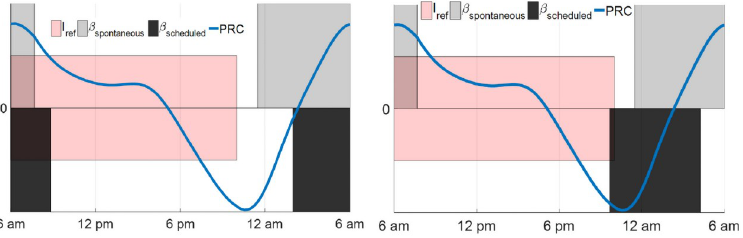
Fig 6. (Left) Scheduled sleep with B sleep = 0.77, B wake = 0.17. (Right) Scheduled sleep with B sleep = 0.67, B wake = 0.27. The red region represents that the reference light is present between 6 am and 10 pm, the gray region in each figure shows the spontaneous sleep period, the blue line shows the value of phase response curve. The black region in the left panel shows the scheduled sleep period that the subject wakes up when B = 0.17 and falls asleep when B = 0.77; the black region in the right panel shows the sleep period that the subject wakes up when B = 0.27 and falls asleep when B =